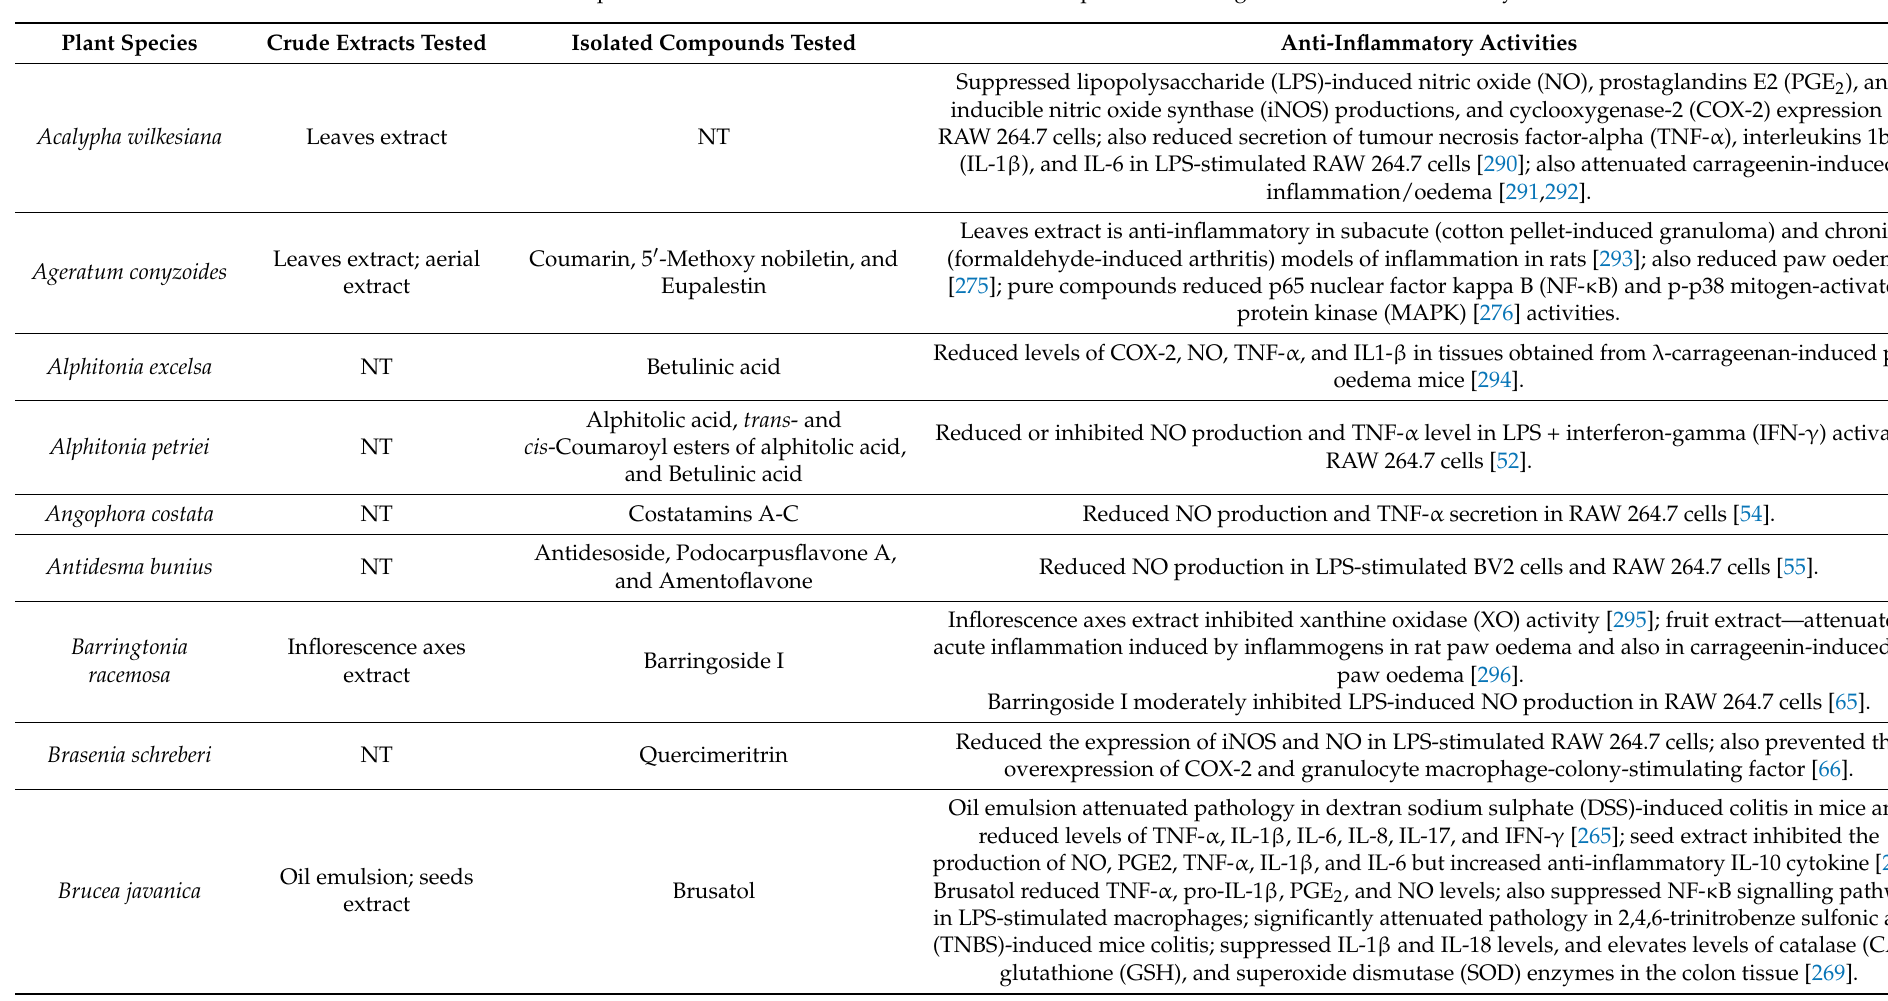
Table 2. List of medicinal plants and their crude extracts and/isolated compounds showing various anti-inflammatory